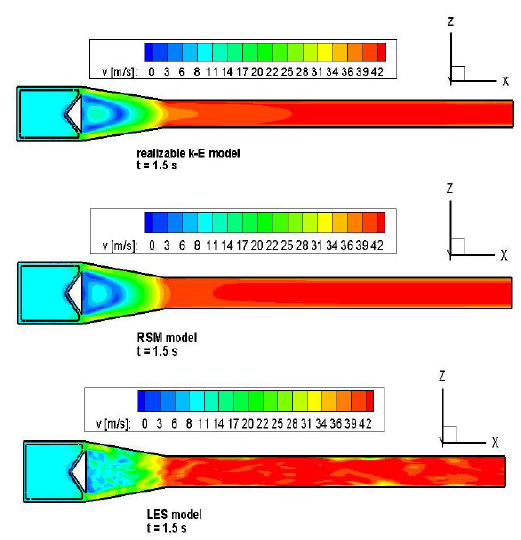
Figure 10. Velocity distribution along the chamber axial cross- section for the three turbulent models for t=1.5